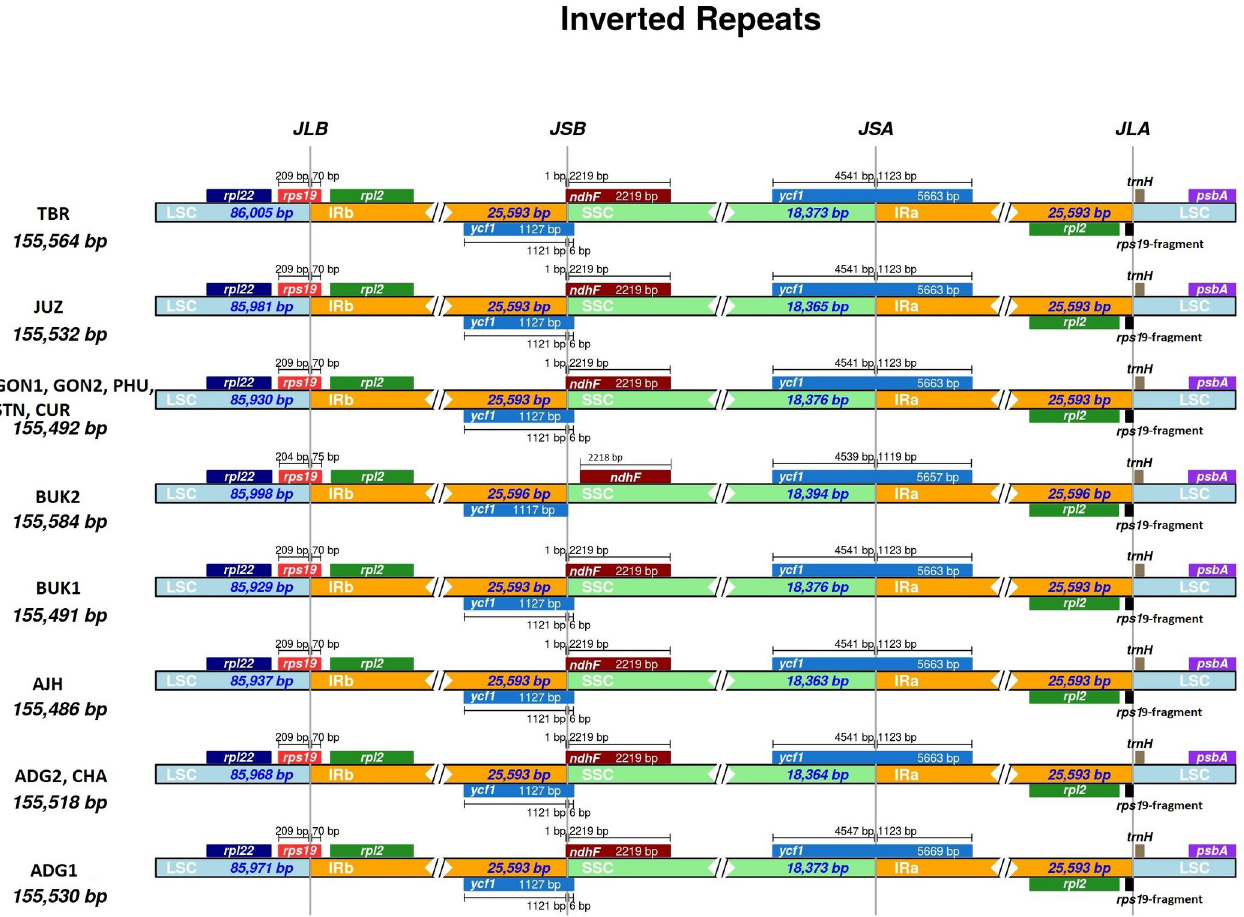
Fig 2. Representation of junction-sites in 13 potato plastomes. Four junction sites are present in all the plastomes, JLB (LSC-IRb junction), JSB (IRb-SSC junction), JSA (SSC-IRa junction), JLA (IRa-LSC junction). The BUK2 plastome differs from the other by the locations of the junctions.